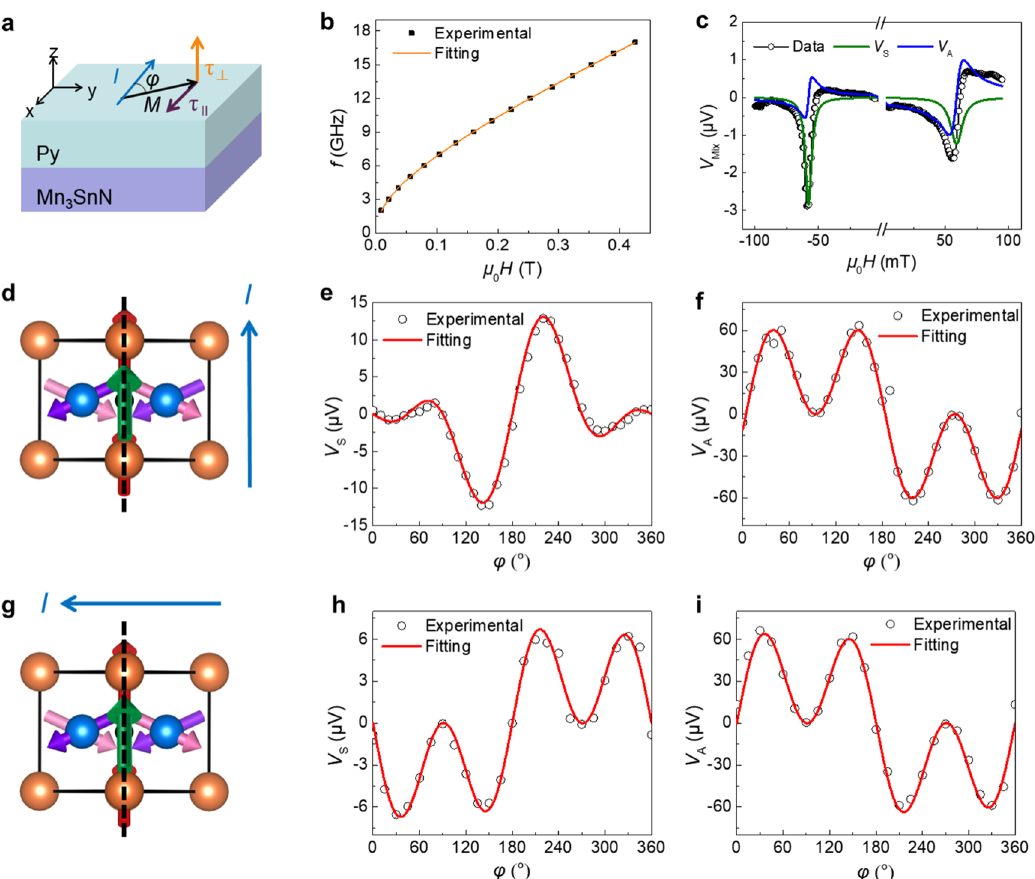
Fig. 3 Current direction-dependent σ z in (110)-orientated Mn 3 SnN device. a Schematic diagram of the ST-FMR geometry for Mn 3 SnN(110)/Py bilayers. τ τ ⊥ denote the in-plane and out-of-plane torque components. b The relationship o f the frequency f and the resonance position H || and 0 , which can be well fi tted by the Kittel formula. c ST-FMR signals V φ of 100° when the mix of the device bar measured with the frequency of 5 GHz, power of 20 dBm, and current channels are along the [001] direction. d Schematic diagram of magnetic structure and current direction. The current is applied parallel to the magnetic mirror plane (represented by the dashed black line). Angular dependence of line shape amplitude of ST-FMR signals for e symmetric and f antisymmetric signal in Mn 3 SnN/Py structure. g The schematic diagram for the case when the current direction is perpendicular to the magnetic mirror plane. Angular dependence of line shape amplitude of ST-FMR signals for h symmetric and i antisymmetric signal in the same